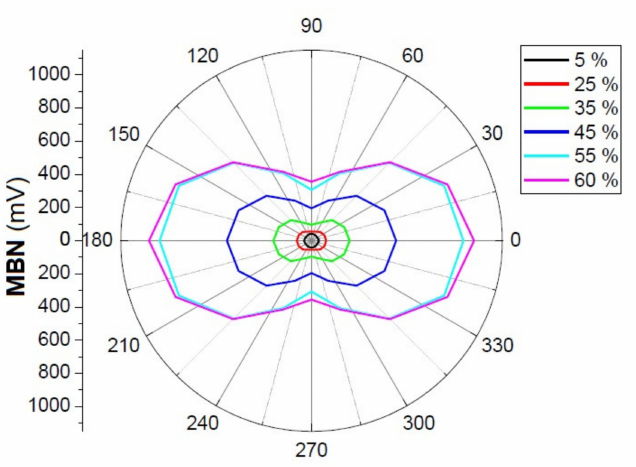
Figure 9. Angular dependence of Magnetic Barkhausen Noise (MBN) for different ε